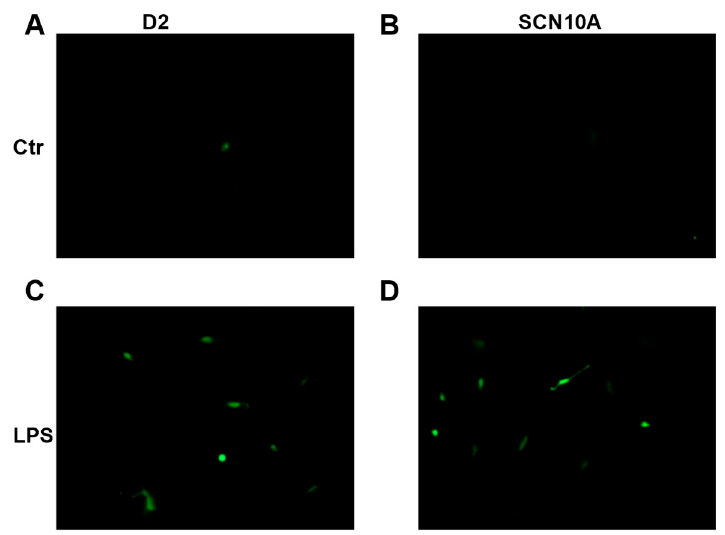
Figure 7. LPS-induced ROS generation in the donor and BrS-hiPSC-CMs. Cells from D2 donor (Ctr) and BrS-patient (SCN10A) were incubated with LPS (2 µ g/mL) for 48 h. Next, hiPSC-CMs were washed twice and incubated with 5 µ M DCFH-DA solution in serum-free medium at 37 ◦ C for 30 min in the dark. A fluorescence microscope was employed for evaluating the DCF fluorescence of cells on coverslips. ( A , B ) Fluorescence intensity in control cells (Ctr) without LPS treatment. ( C , D ) Fluorescence in the LPS treated cardiomyocytes. Magnification, × 400.